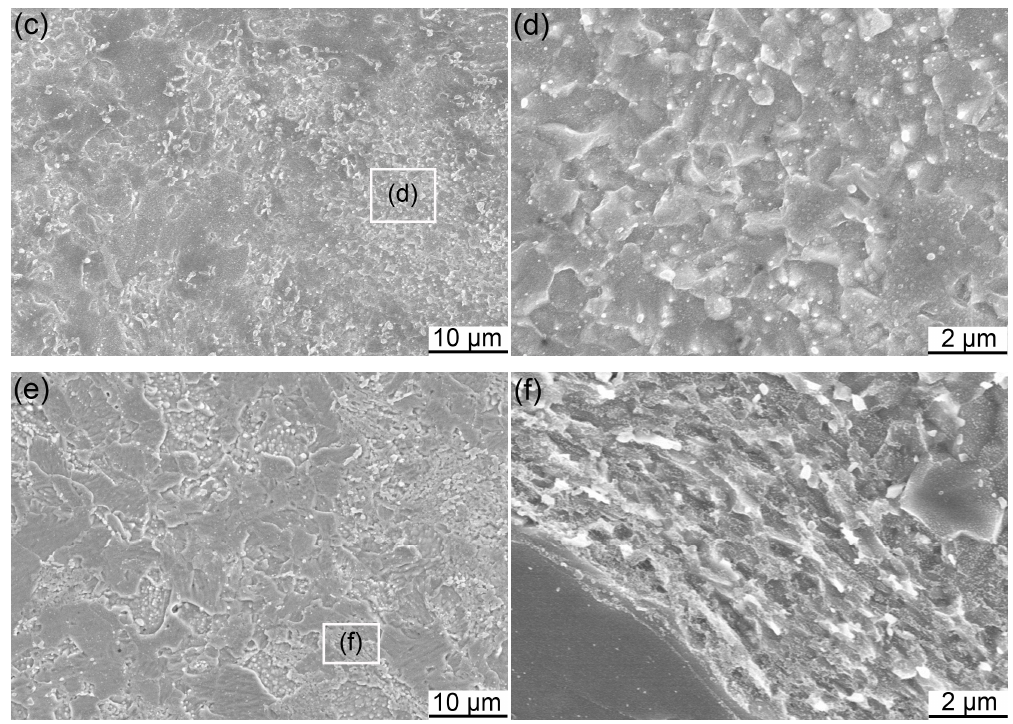
Figure 6. Scanning electron microscope (SEM) images of polished and etched samples at different magnifications: ( a , b ) MP; ( c , d ) MX; ( e , f ) ODS.